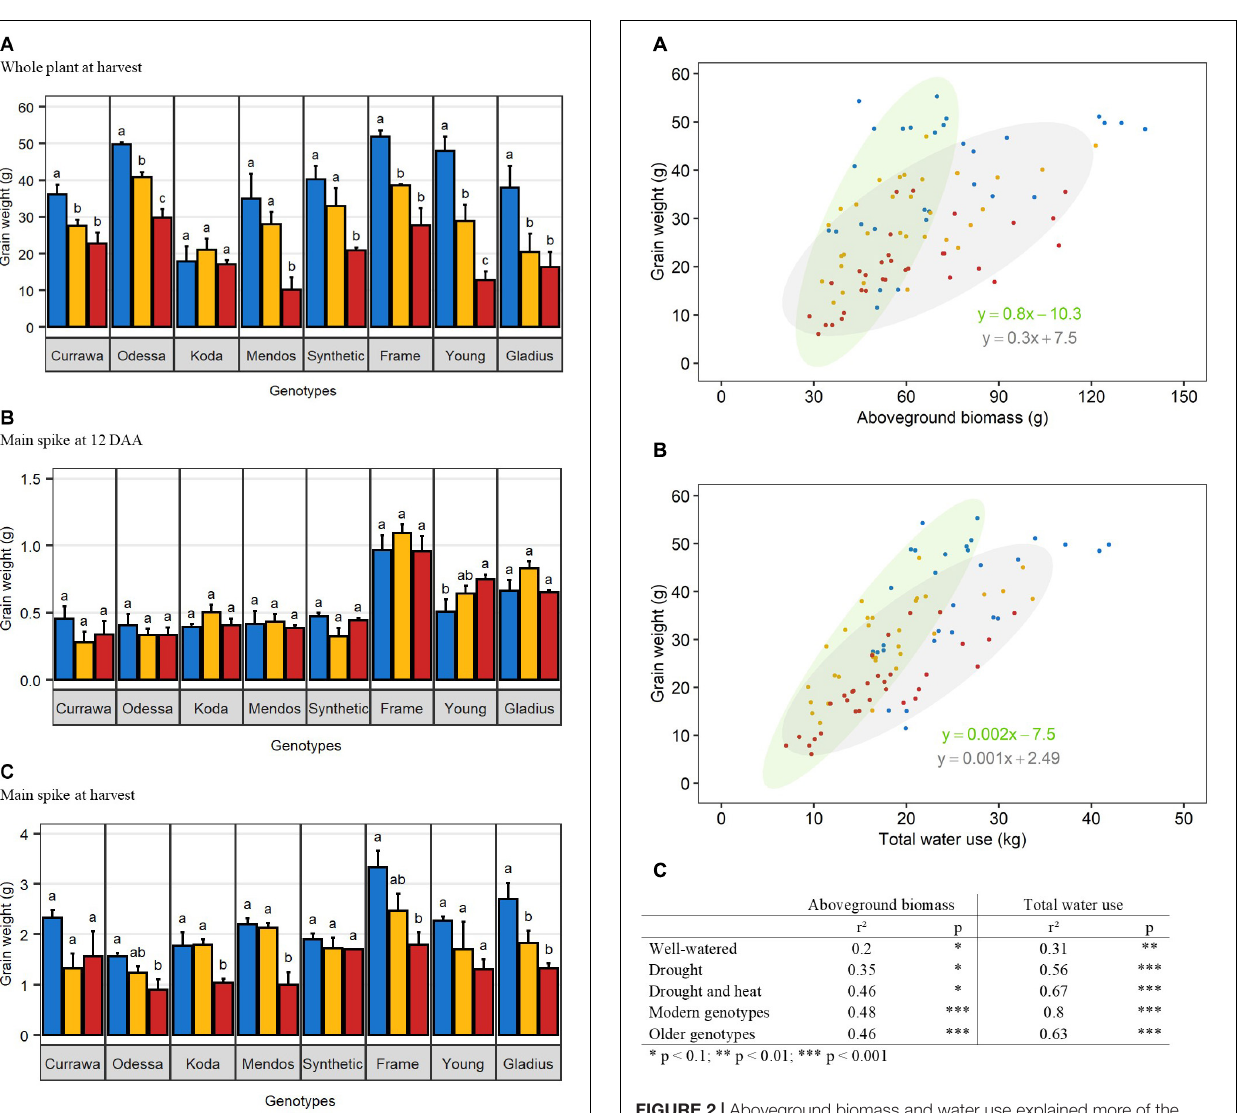
FIGURE 2 | Aboveground biomass and water use explained more of the variation in grain weight under increasing stress intensity than in well-watered conditions. Relationships between final grain weight per plant and (A) final aboveground biomass excluding grains, (B) total water use. Each point represents one plant, grown under well-watered conditions (blue), drought (orange) or combined drought and heat stress (red). Ellipses circle modern genotypes (in green) and older genotypes (in gray). Linear regression equations correspond to linear regression for modern genotypes (in green) and older genotypes (in gray). (C) Table shows r 2 and p -value of linear regressions (* p < 0.1, ** p < 0.01, *** p < 0.001) for each treatment (well-watered, drought, combined drought, and heat stress) and genotype group (modern,